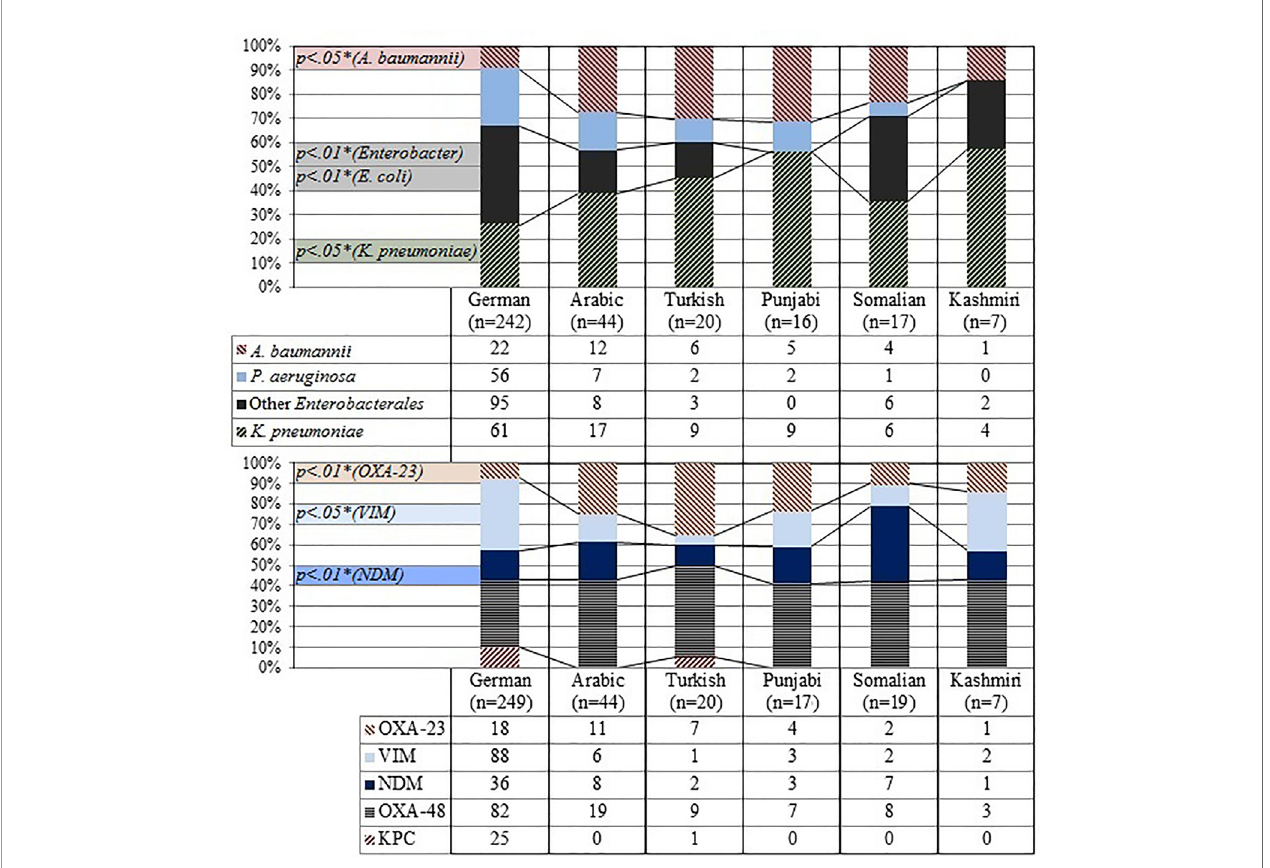
FIGURE 3 | Summary of patient ethnicity and frequency of species and carbapenemases.*P-values refer to the signi fi cance of the point estimates in the regression analysis, baseline category for ethnicity is German (see Appendix B